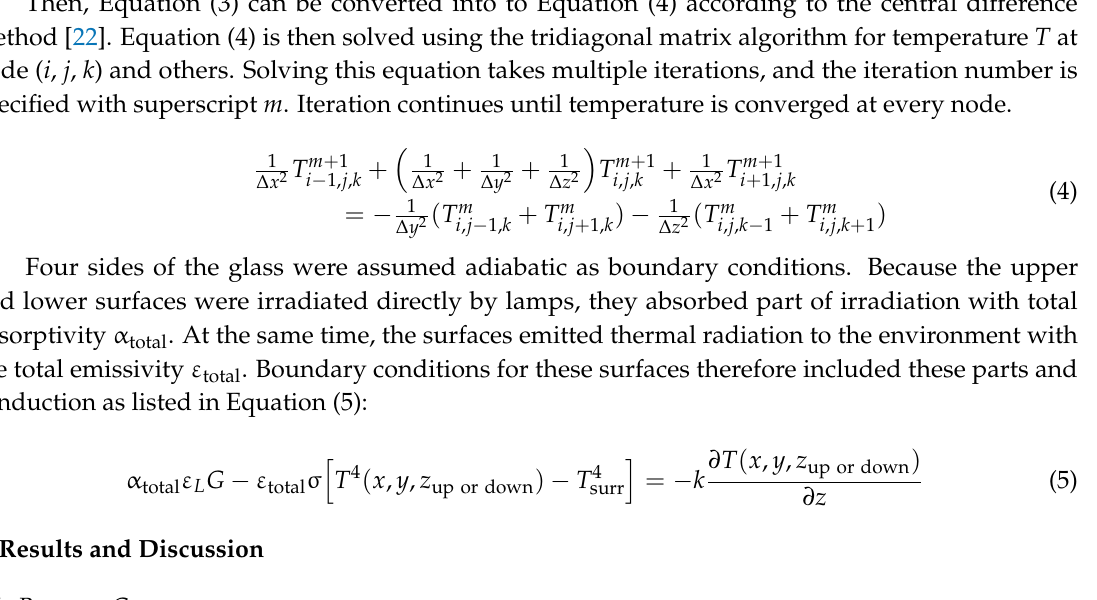
Figure 5b chooses one of 27 combinations to make a grid convergence test. The control factors of this oven were l / L = 0, h 1 / H = 0.5, and h 2 / H = 0.5, and the grid sizes for the test were ∆ y = 1.75, 3.5, 7, and 14 mm, respectively. The upper and lower subgraphs show the convergence of the average temperature T avg and the maximum temperature difference ∆ T max with the iteration number m , respectively. Results showed that the results of the previous four mesh sizes were all convergent when the number of iteration times m was about 300,000. In addition, the average temperature T avg was consistent with the maximum temperature difference ∆ T max when the size of the grid was ∆ y ≤ 7 mm. To ensure convergence and consider the spatial temperature distribution resolution, the grid was set as ∆ y = 1.75